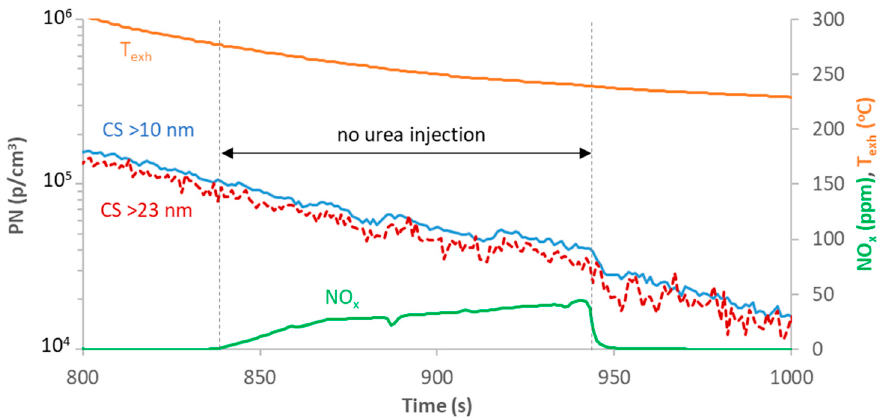
Figure 3. Nonvolatile particle number (PN) emissions > 23 nm and > 10 nm with and without urea injection as measured with the system with catalytic stripper (CS1). PN instruments measuring from the dilution tunnel, while NO x from the tailpipe.